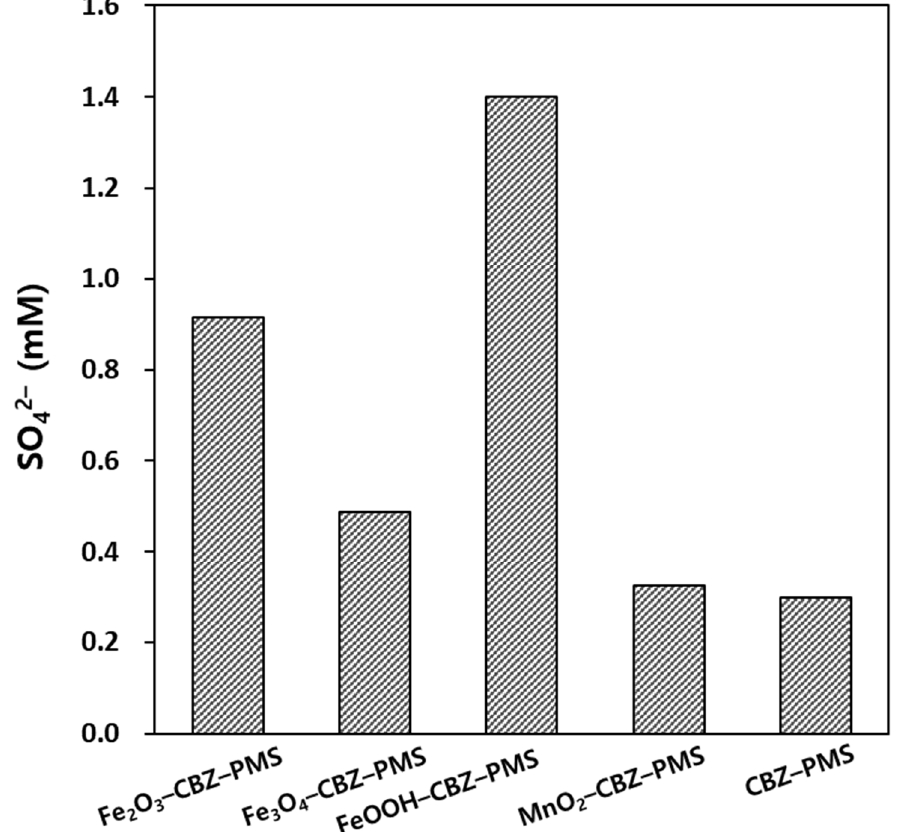
Figure 3. The concentration of SO 42 − generated from PMS in CBZ decomposition experiments ([CBZ] = 10 µM, [PMS] = 200 µM, [metal oxide] = 0.1 g/L, [borate buffer solution] = 18.75 mM, [pH] = 7.5~8.0, reaction time = 7 d).